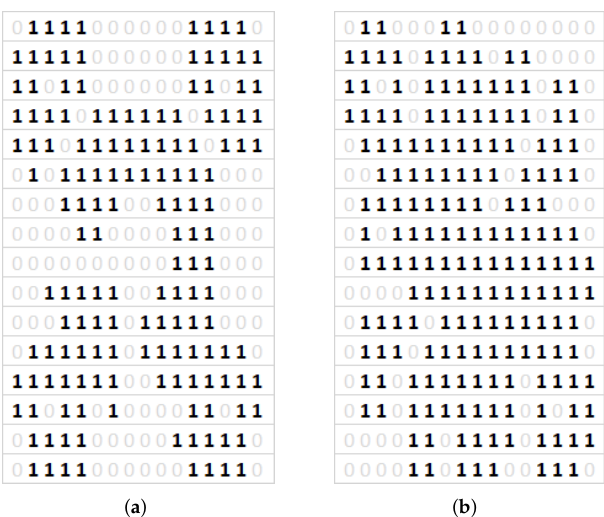
Figure 19. Binary pattern for complex Chladni’s figures from acquired images classified as ( a ) model Figure 16b, ( b ) model Figure